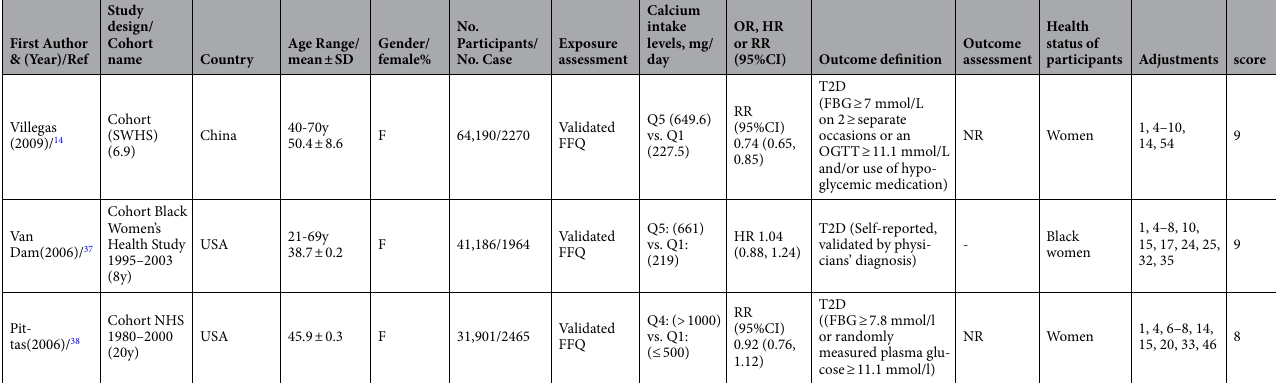
Table 2. Main characteristics of included studies examined the association between dietary Ca intake and T2DM/hyperglycemia. 1-Age, 2-gender, 3-race, 4-BMI, 5-education level, 6-exercise, 7-smoking status, 8- alcohol use, 9-economic status, 10- energy intake, 11-vitamin D intake, 12- dialect, 13-year of interview, 14-hypertension, 15-diabetes, 16-potasium intake, 17-mangasium, 18-phosphorius, 19-calcium, 20-multivitamins, 21-zinc, 22-vegetable intake, 23-fruit, 24-meat, 25-processed meat, 26-poultry, 27-fish, 28-nut, 29-seed, 30-grains, 31-legums, 32-coffee, 33-caffeine, 34-soda, 35-sugar-sweetened drink, 36-fiber, 37-protein, 38-carbohydrate, 39-fat, 40-cholestrol, 41-sodium, 42-polutary, 43-soy, 44-FBG, 45-glycemic load, 46-residential area, 47-season, 48-MetS components, 49-eGFR, 50–25(OH)D levels, 51-WC,